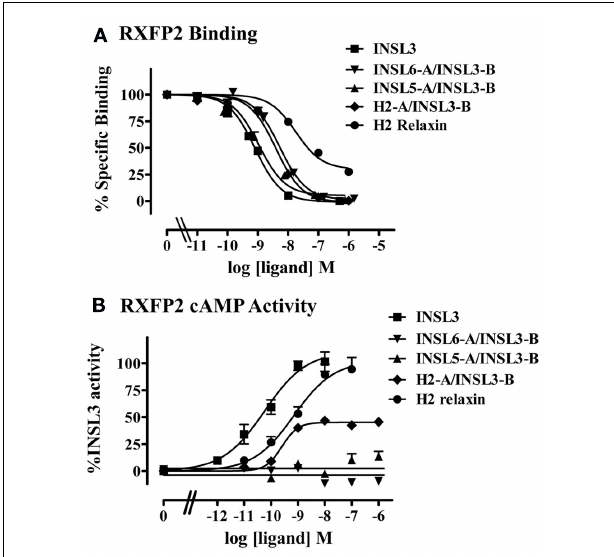
FIGURE 2 |Activity of the INSL3 chimeric peptides on the RXFP2 receptor. (A) Competition binding utilizing Eu-labeled INSL3 compared to INSL3 and H2 relaxin. Data are expressed as the percentage of specific binding and are pooled from at least three experiments with triplicate determinations within each assay. (B) cAMP activity compared to INSL3 and H2 relaxin measured utilizing a pCRE– β -galactosidase reporter gene assay. Data are expressed as the percentage INSL3 maximum activity and are pooled data from at least three experiments with triplicate determinations within each assay.